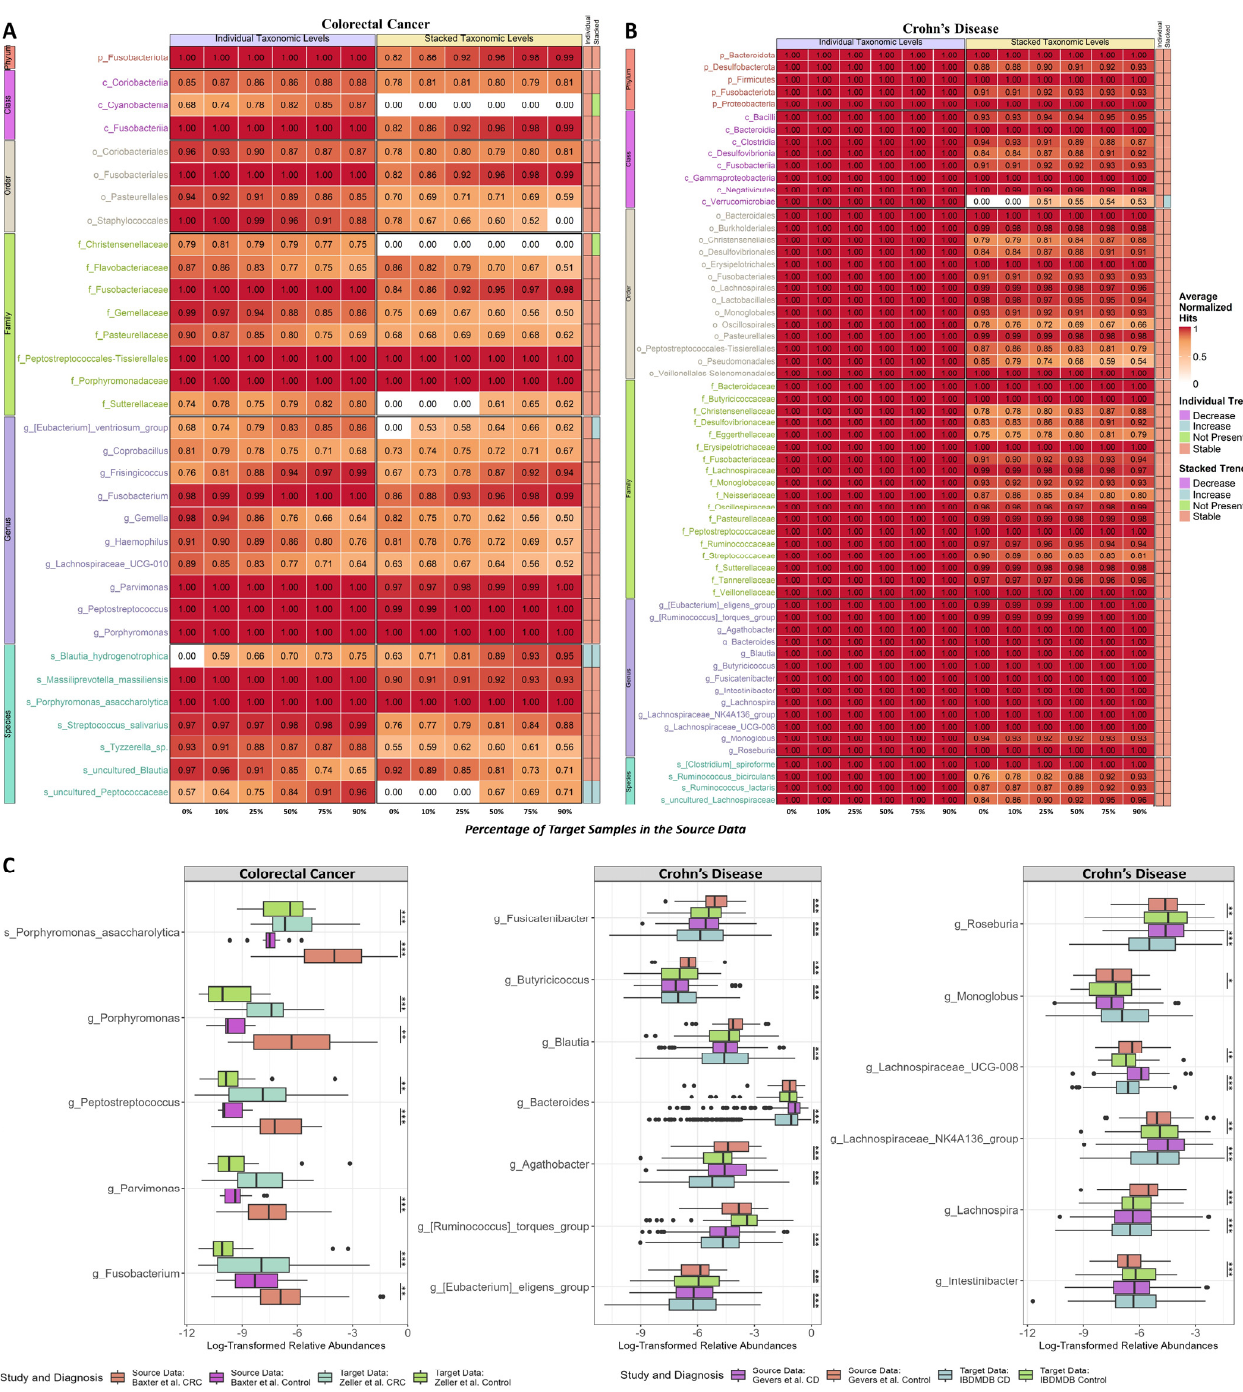
Figure 5. The top features of the random forest feature selection results for colorectal cancer and Crohn’s disease datasets were investigated for changes as the percentage of target samples in the source data increased. ( A ) presents a heatmap of the changes in the top 33 features for the colorectal cancer datasets at the individual taxonomic and stacked-taxa levels, while ( B ) shows the changes in the top 64 features for the Crohn’s disease datasets. ( C ) displays the log-transformed relative abundances for the consistent taxa identified between the individual taxonomic and stacked-taxa levels for the colorectal cancer and Crohn’s disease datasets. The solid black dots represent outliers. Taxa with a change of less than 0.15 between the baseline and importance with 50% of target samples in the source data were labeled as stable. Changes greater than 0.15 or less than − 0.15 were labeled as increases or decreases, respectively. Taxa that were not selected as important by any of the models